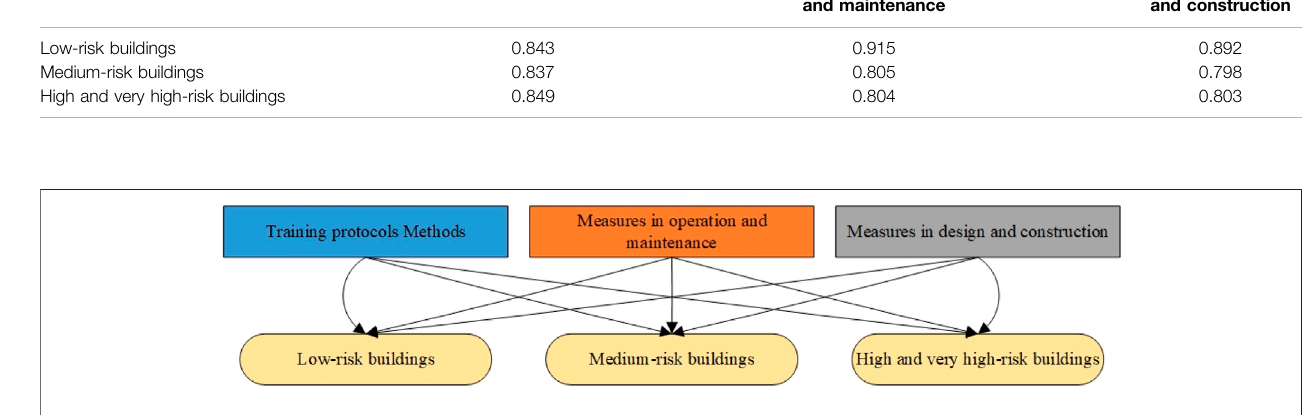
FIGURE 1 | The hypothetical model for consideration in this